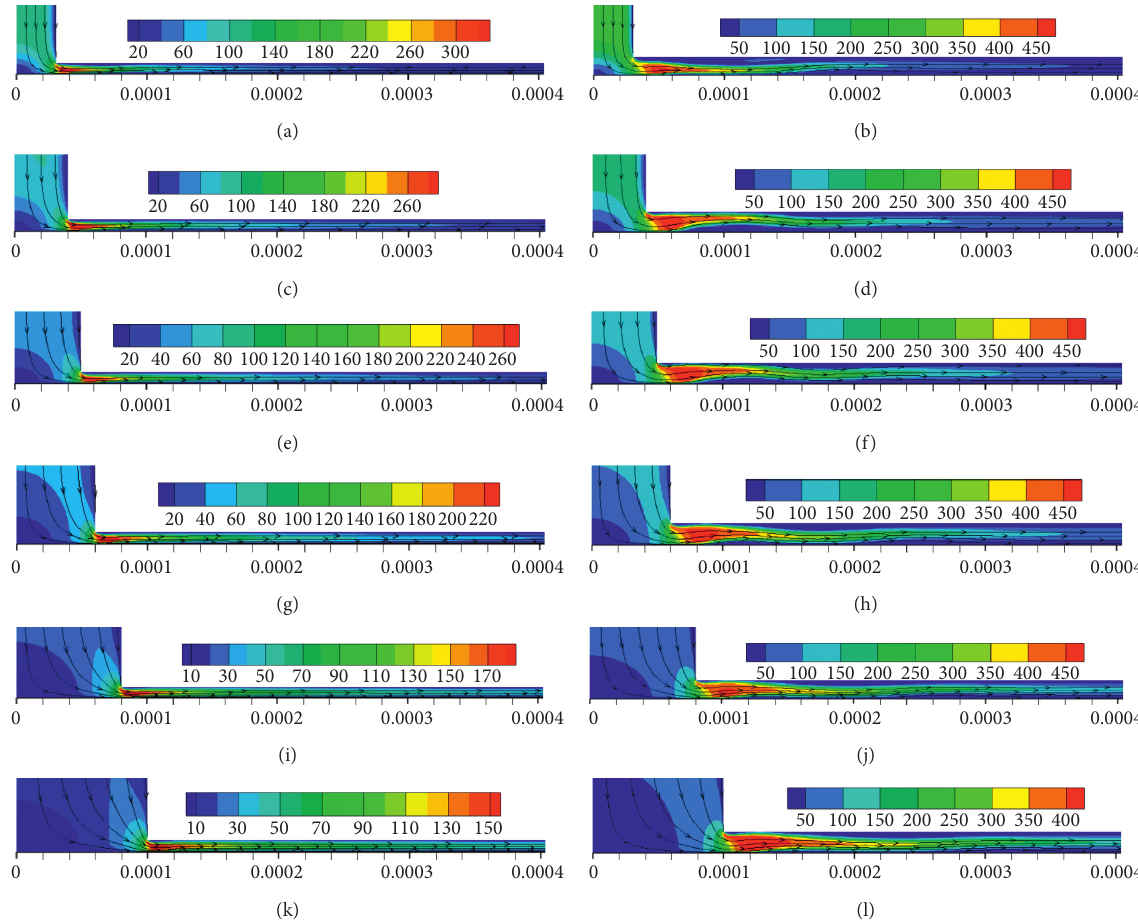
Figure 15: Cloud chart of the velocity of the gas film at different d . (a) d � 0.06mm, h � 8 μ m, (b) d � 0.06mm, h � 16 μ m, (c) d �